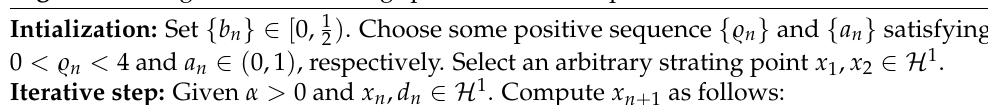
Algorithm 1 Algorithm for solving split minimization